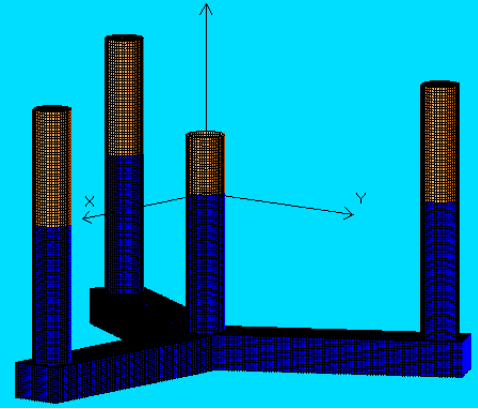
Figure 7. Panel mesh model of the braceless semi-submersible platform.